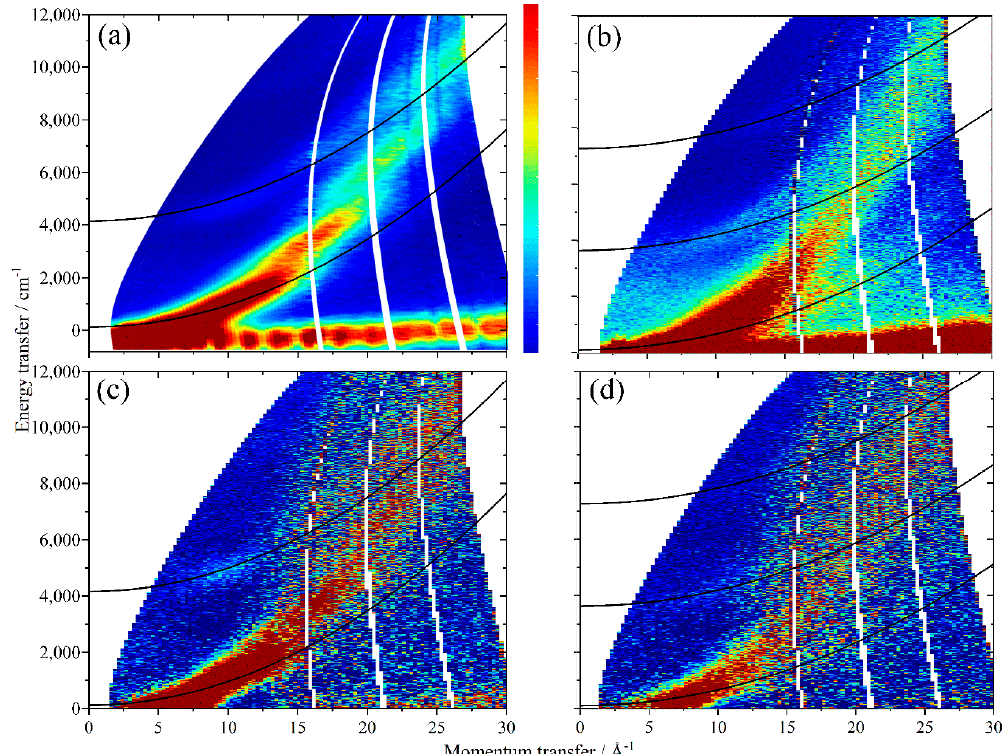
Figure 5. S(Q , ω ) ) maps at 7 K in the high energy region ( E i = 16,000 cm − 1 ) of ( a ) H 2 , ( b )solid HD, ( c ) difference spectrum ((Fe-BTC + H 2 )-(clean Fe-BTC)) and ( d ) difference spectrum ((Fe-BTC + HD)-(clean Fe-BTC)). In ( a , c ), the solid lines show the recoil trajectories of the ν = 1, J = 0 (upper) and ν = 0, J = 1 (lower) lines and in ( b , d ), the ν = 2, J = 0 (top), ν = 1, J = 0 (middle) and ν = 0, J = 1 (bottom). The ideal trajectories are parabolae in (Q, ω ) and are shown by the solid black lines; these are calculated for the ν = 0, J = 1 (lower) and ν = 2, J = 0 (upper) states. The experimental data deviate from